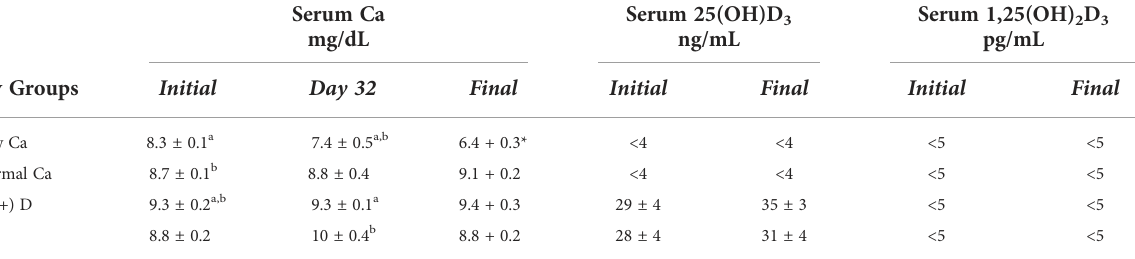
TABLE 1 Serum parameters in vitamin D-de fi ciency